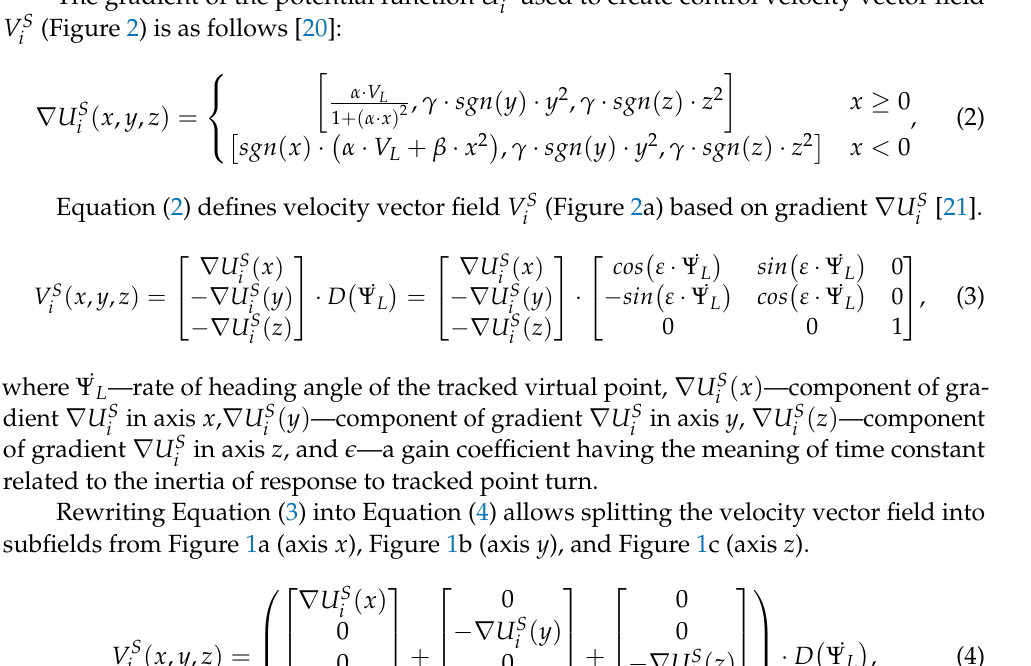
Figure 2. ( a ) The velocity field V S acceleration, the zone with a blue vector is the zone of deceleration, ( b ) potential field U S of x and y , z is constant